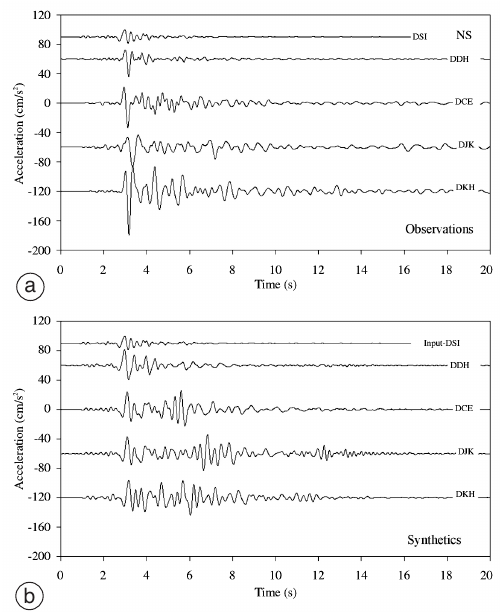
a Fig. 9a,b. Comparison of synthetic and observed seismograms in the time domain for the event oc- curred on October 11, 1995 ( M L = 4.1): a) accelero- grams recorded by the temporary network; b) synthet- ic accelerograms obtained by convolution of the ob- served record at DSI with the corresponding 2D trans- fer function at each location. All traces have been low- pass filtered with a cutoff frequency of 4 Hz.